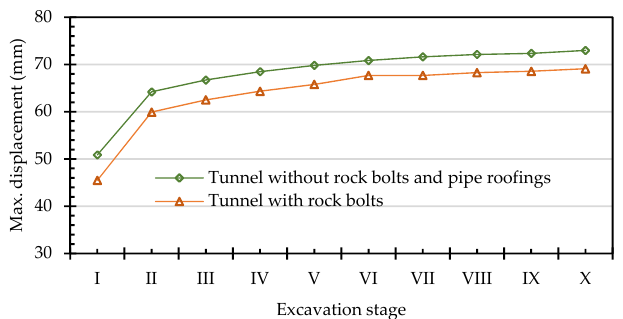
Figure 32. Maximum displacement at various excavation stages with and without rock bolts.